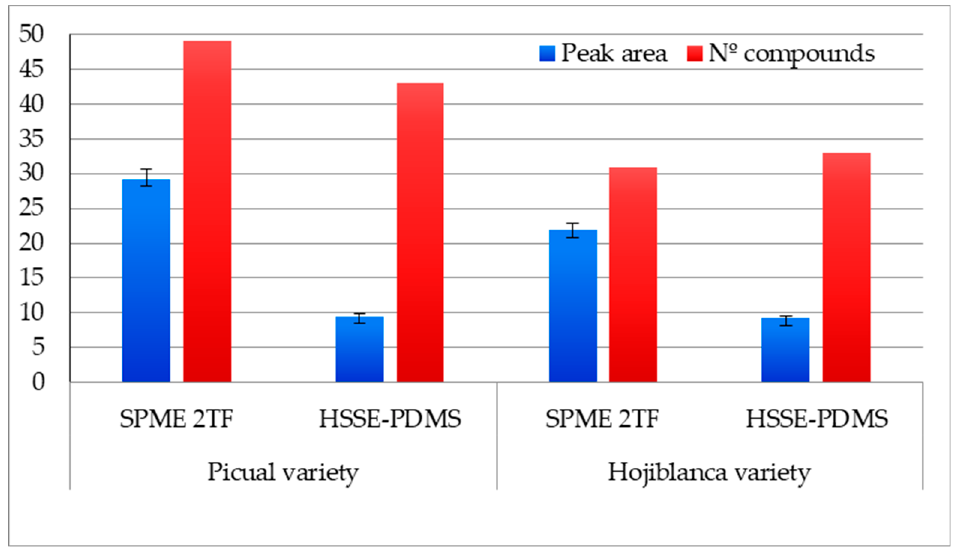
Figure 1. Values of total peak area (divided per 10 7 ) and number of volatile compounds of EVOO Picual and Hojiblanca varieties obtained by HSSE-PDMS and 2TF-SPME. Error bars show standard deviation (SD) values.